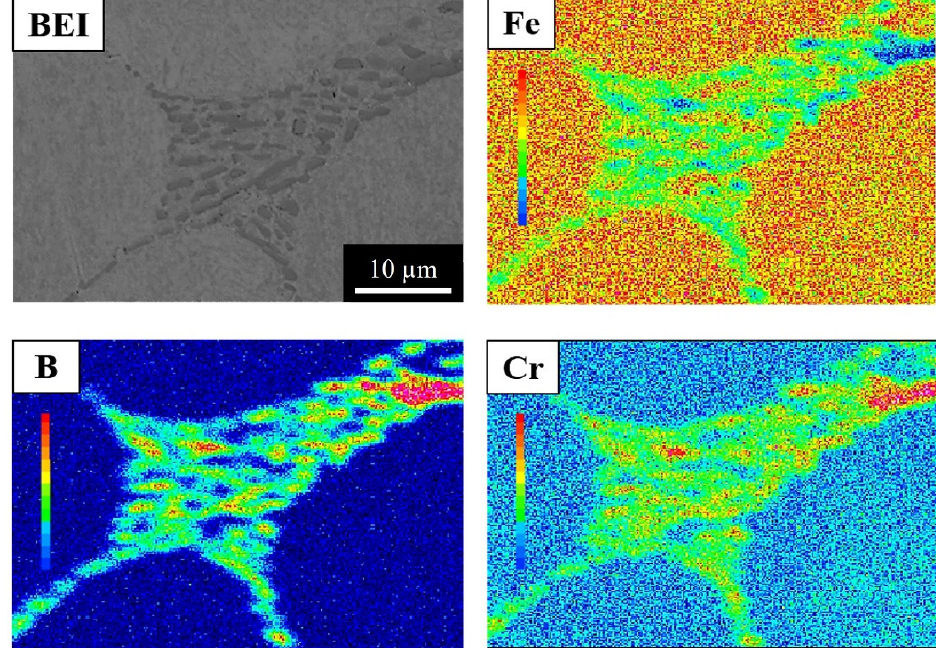
Figure 7. EPMA elemental distributions of 410L + 0.6B steel sintered at 1250 °C for 1 h in hydrogen.